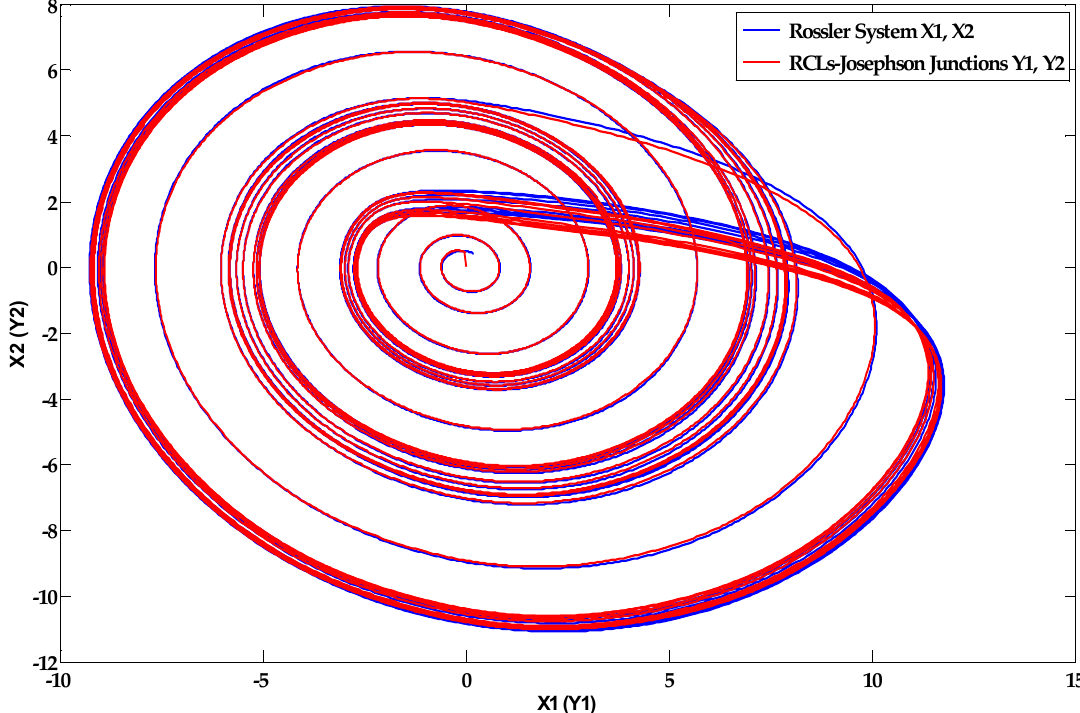
Figure 5. The phase portrait of x 1 ( y 1 ) and x 2 ( y 2 ) using the iterative learning control update law.